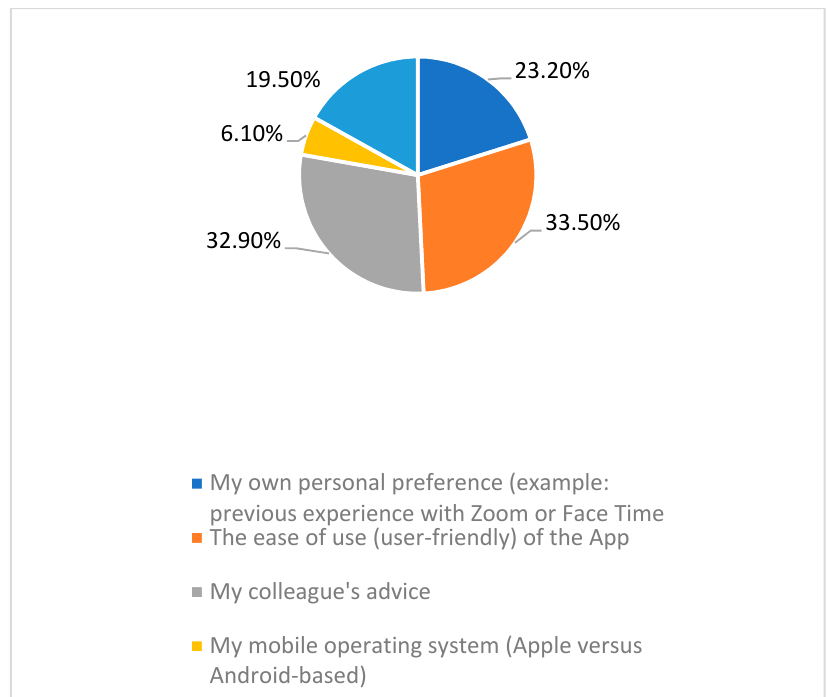
Figure 3. Faculty members’ motive of video conferencing tools choice